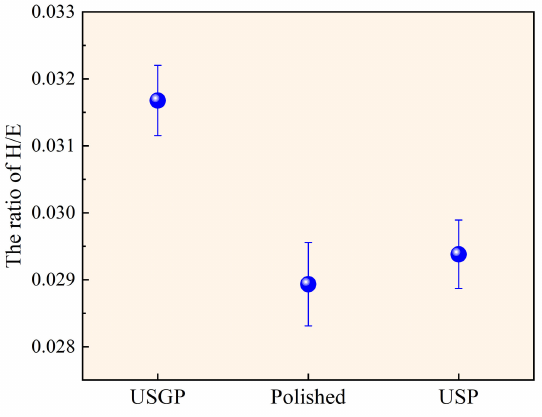
Figure 10. The H / E value variation of the sub-surface of USGP, USP, and polished samples.